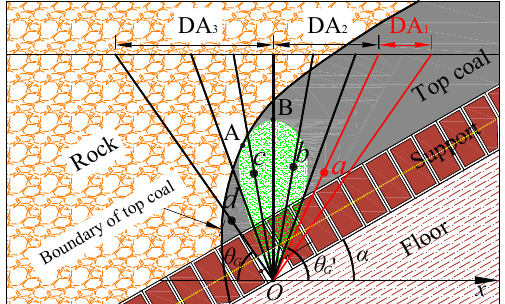
Fig. 11 Theoretical model of drawing body in the normal drawing stage in an inclined